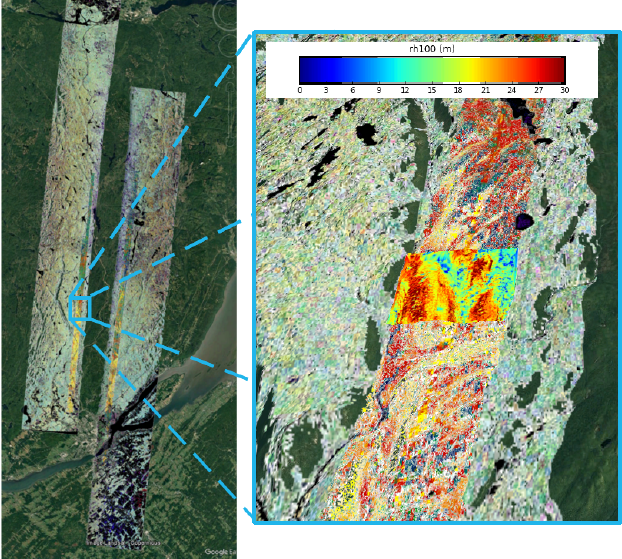
Figure 15. Left : overview of UAVSAR and LVIS datasets on Laurentides. Right : Study